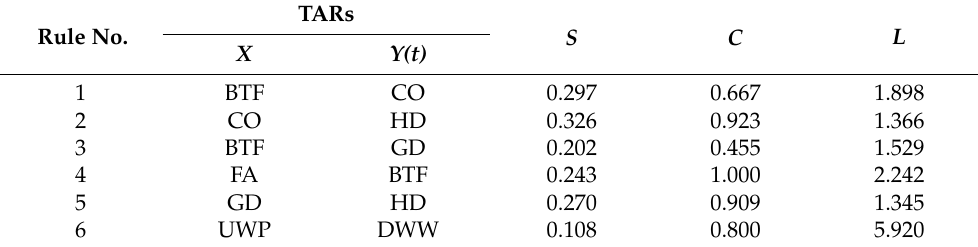
Table 4. TAR results for general cargo ships.